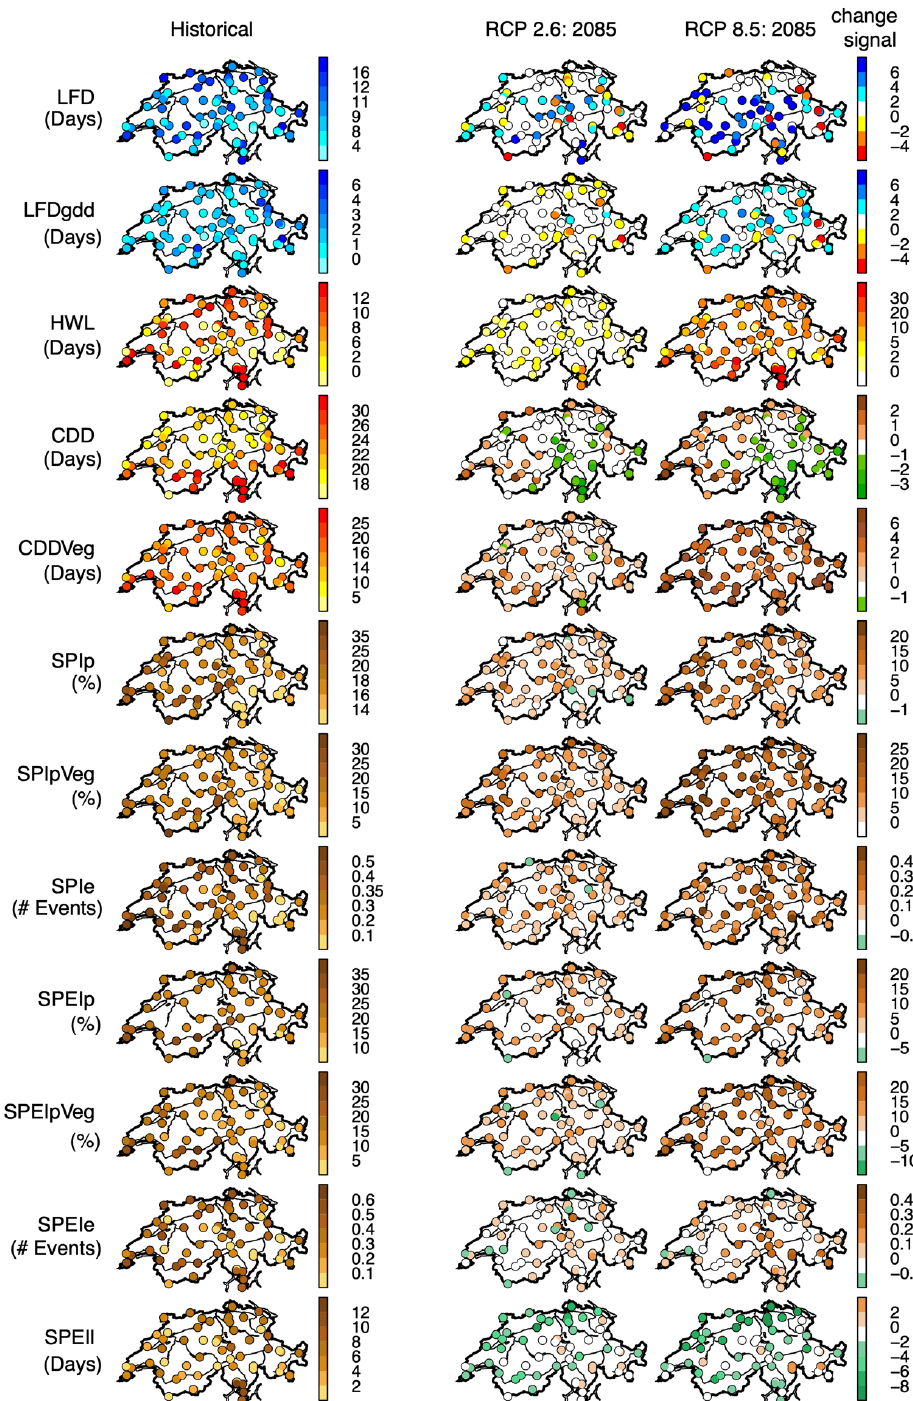
Figure 4. Overview on change signals of class B indices (one index per row). The first column ( left column ) shows the values of the respective index during the historical period as derived from observations. The second and third columns show the median of the change signal between the historical period and the period 2085 for RCP2.6 ( central column ) and RCP8.5 ( right column ). The multi-model median values of the change signal are shown.